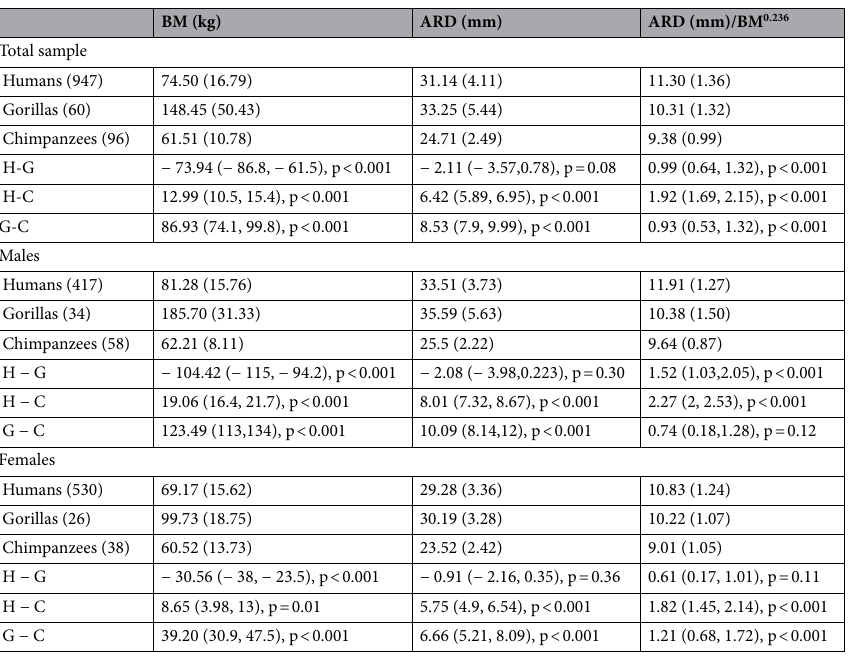
Table 1. The mean (SD) and mean difference (95% CI) and p values, for body mass (BM), aortic root diameter (ARD), and aortic root diameter scaled to body mass raised to 0.236 for the three species and considering sex. BM body mass, ARD aortic root diameter. Sample sizes vary between 1 and 6 cases for different subsamples and variables (see TABLESUPP), maximum sample sizes are shown. Statistical significance of the Games– Howell post hoc tests with Bonferroni-Holm correction (72 tests) are indicated. * P < 0.05. H − G humans minus gorillas, H − C humans minus chimpanzees, G − C gorillas minus